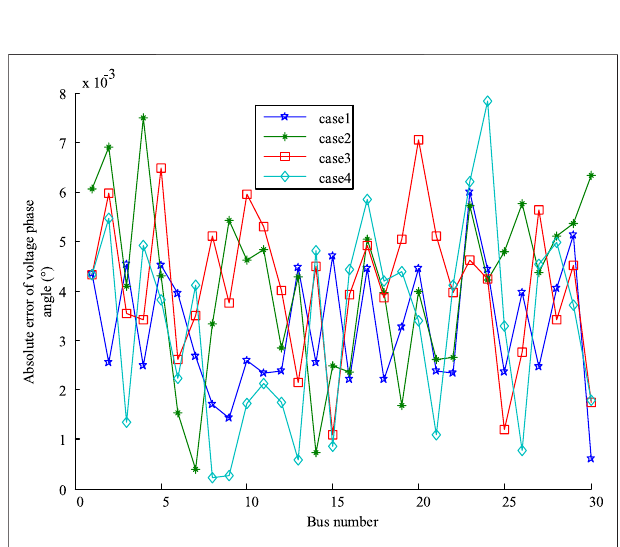
FIGURE 7 | The absolute error of the voltage phase angle of each method under Laplace measurement noise.